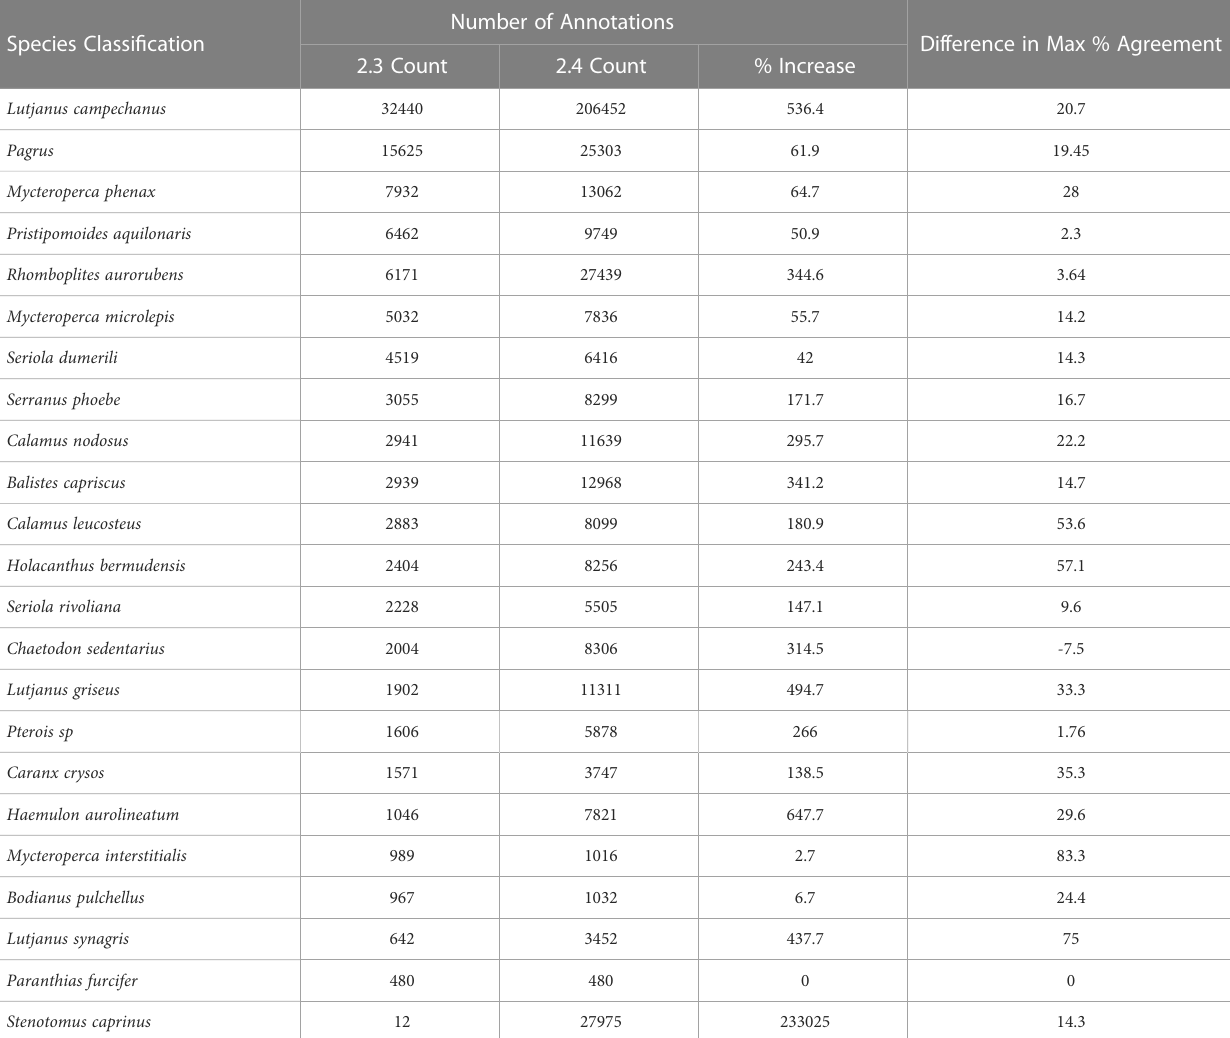
TABLE 2 Count of annotations per species that contributed to the training library for each model and the difference in maximum percent agreement between iteration 2.3 and 2.4.